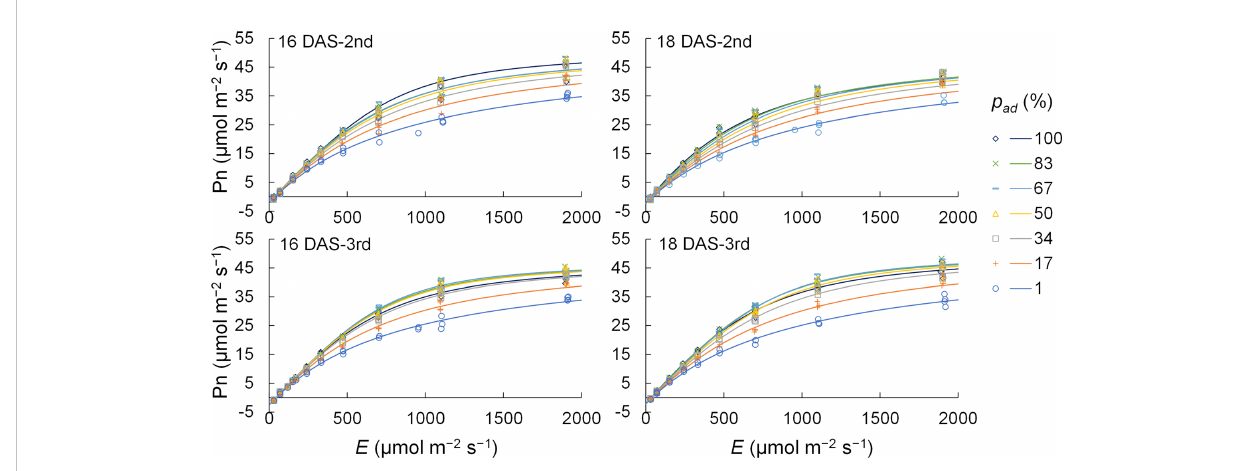
FIGURE 3 The measured ( n = 148 – 178) and calculated values of net photosynthetic rate (Pn) of the 2nd and 3rd leaves of komatsuna 16 DAS and 18 DAS. E and p ad indicate the total photosynthetic photon fl ux density (PPFD) on the adaxial and abaxial surfaces of a leaf and the proportion of PPFD on the adaxial surface of a leaf to E , respectively. The light response curves of photosynthesis were obtained by the methods detailed in Section 2.3.2.